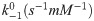
A two-state model of PhoPQ TCS can explain biphasic response.A -Schematic of the two-state model. PhoQ exists in phosphatase (PhoQ) or kinase (PhoQ*) form, PhoQ* assumed to bind Mg2+ and switch to PhoQ. Concentration of Mg2+ in medium assumed constant, and absorbed into a pseudo-first order kinetic rate, k−1 (blue arrow). MgrB reversibly binds PhoQ/PhoQ*. B—Simulated output (normalized YFP:CFP; Methods) from the ODE model representing schematic in A with two rate constants suppressed in MgrB bound PhoQ. The pre-factor k−10(s−1mM−1) converts Mg2+ concentration (mM) to rate constant k−1(s−1). The affected rates are denoted by red arrows: switching rate from phosphatase to kinase (i.e. k1, PhoQ-Mg2+ dissociation), and autophosphorylation. Detailed balance condition is satisfied by assuming PhoQ-MgrB dissociation is suppressed by the same factor as k1. Simulated steady state output shows biphasic response to increasing signal.